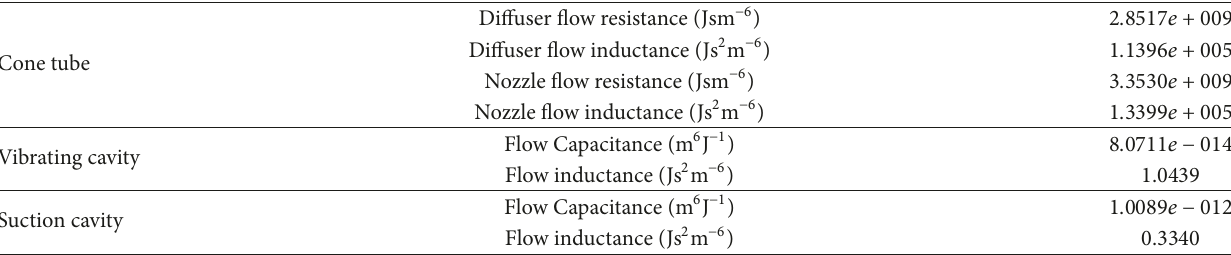
Table 3: Equivalent electrical network parameters of the micropump suction